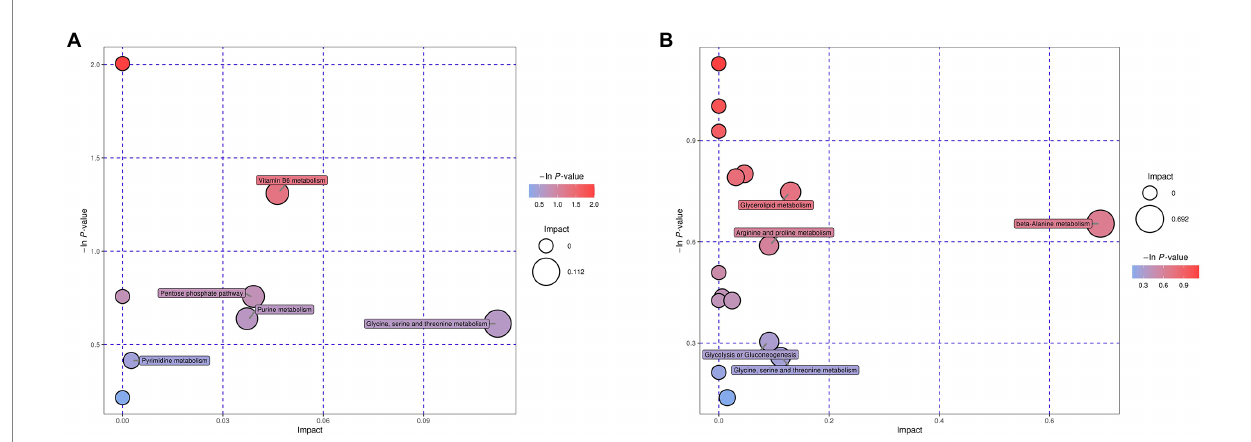
FIGURE 3 Bubble plots of pathway analysis of Salmonella after (A) desiccation treatment and (B) SMP storage. The circle size corresponds to impact values ( x - axis) and the color reflects -ln p -values ( y -axis). The pathway impact values were calculated from pathway topology analysis, which uses betweenness centrality measures to estimate node